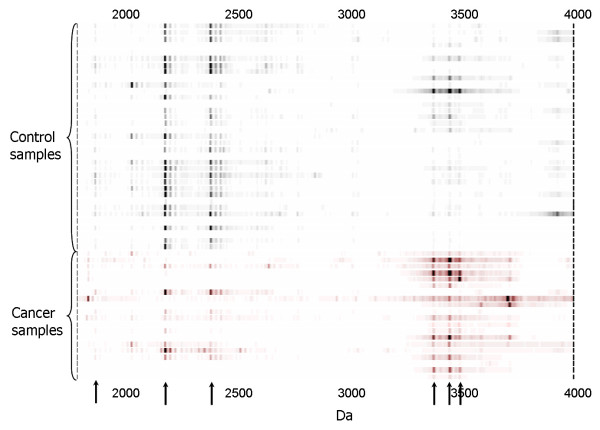
Expression difference map of gastric fluid pellet extract on cation exchange ProteinChip array (WCX2). Arrows indicate protein biomarkers significantly different in expression level between the two groups of samples.